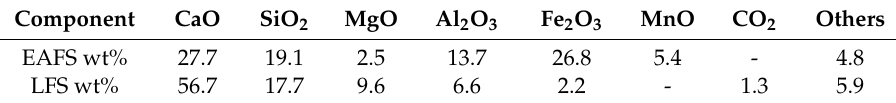
Table 2. Chemical composition of the slags under study.